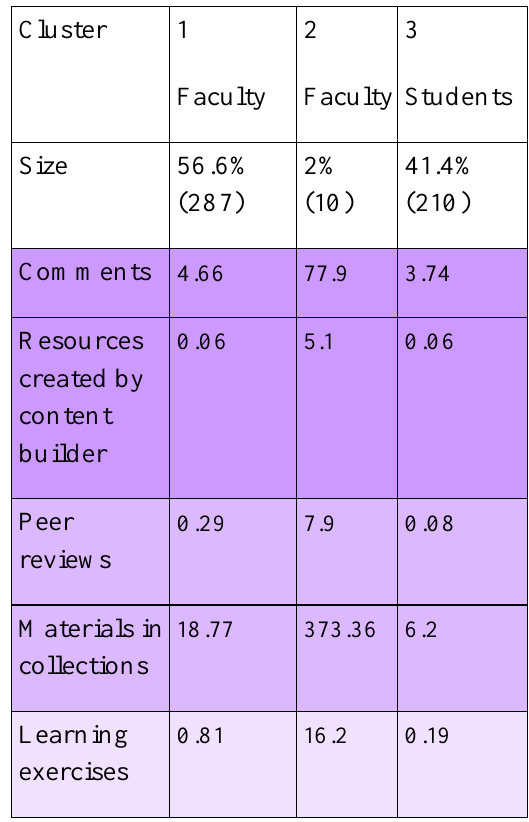
Cluster Descriptions [the colors represent the input (predictor)